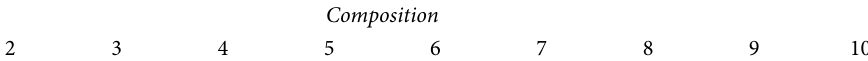
Table 5: Exploratory factor analysis